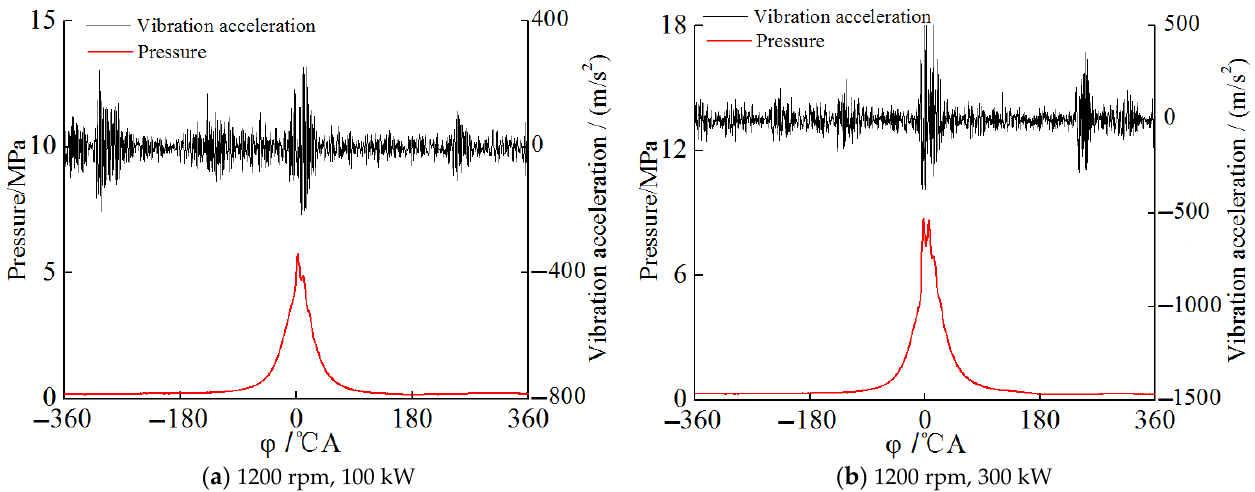
Figure 11. Vibration acceleration and pressure measured under different working condition.